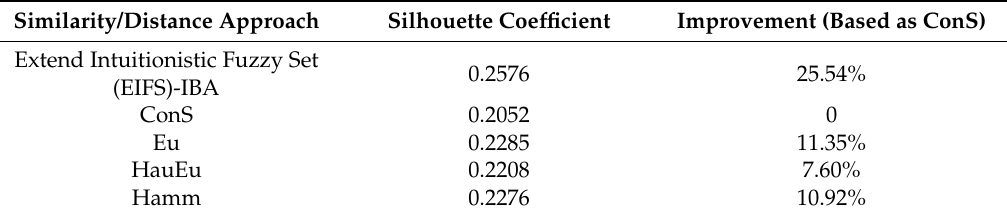
Table 6. The silhouette coefficient of cluster region c